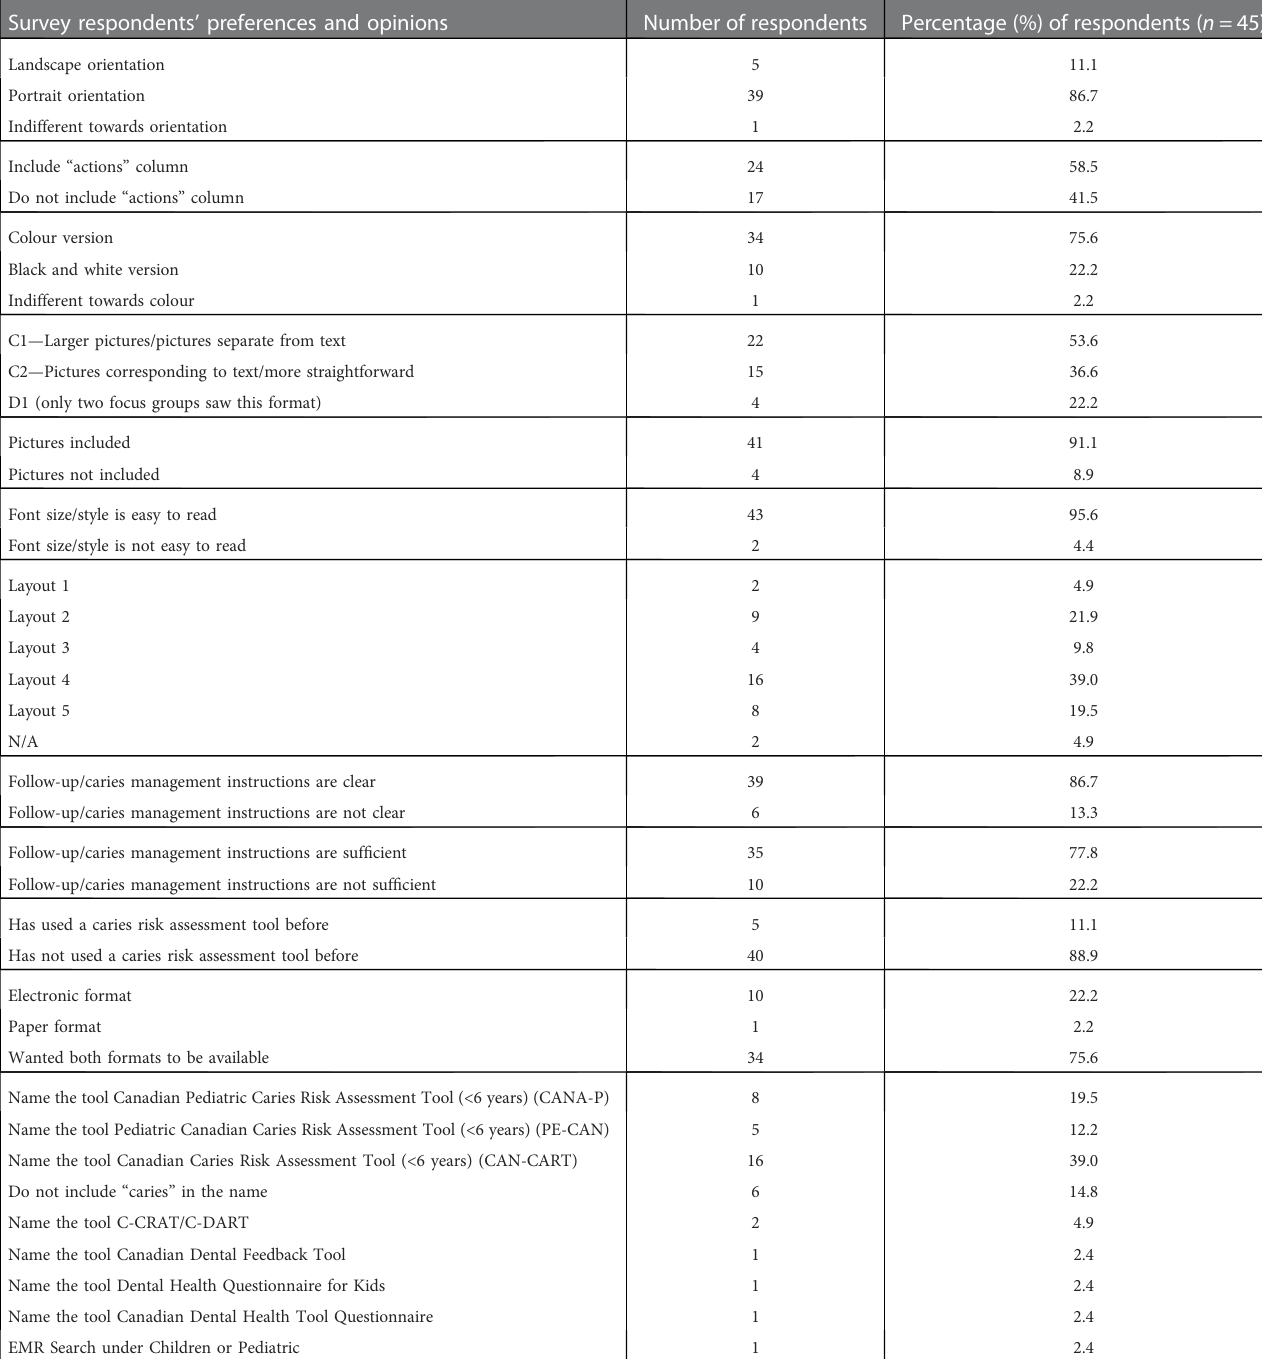
TABLE 3 Survey respondents ’ preferences and opinions toward various attributes of the caries risk assessment tool. Survey respondents ’ preferences and